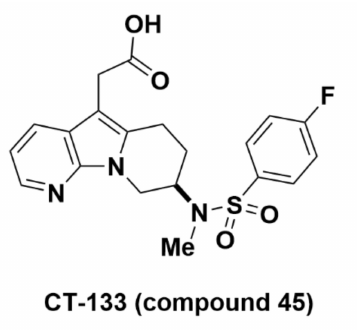
Figure 16. Molecular structure of CT-133 (compound 45